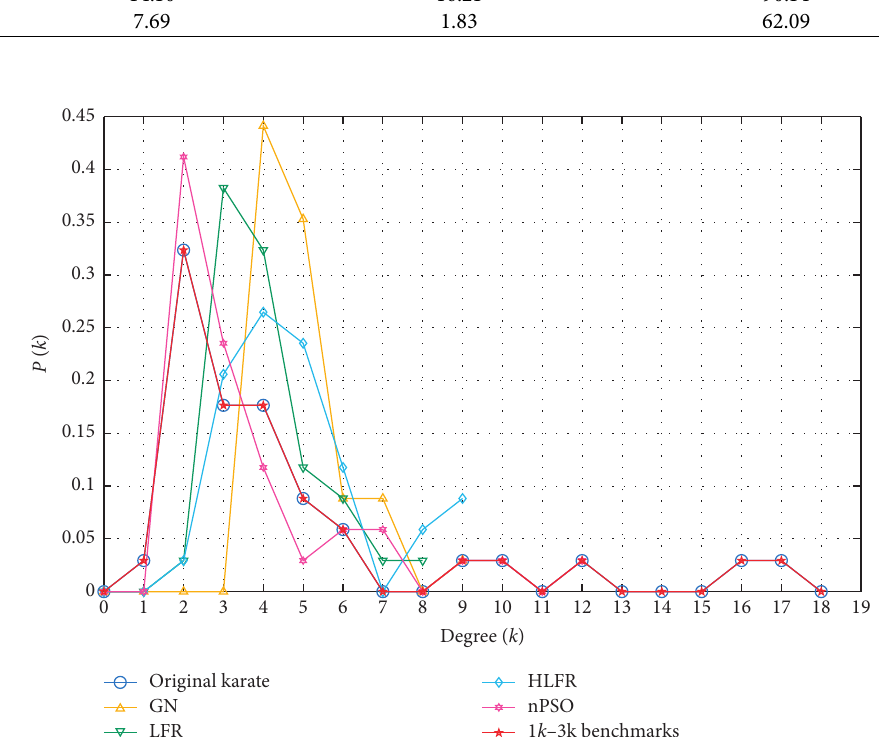
Figure 1: Degree distribution of the original Karate network and seven kinds of generated